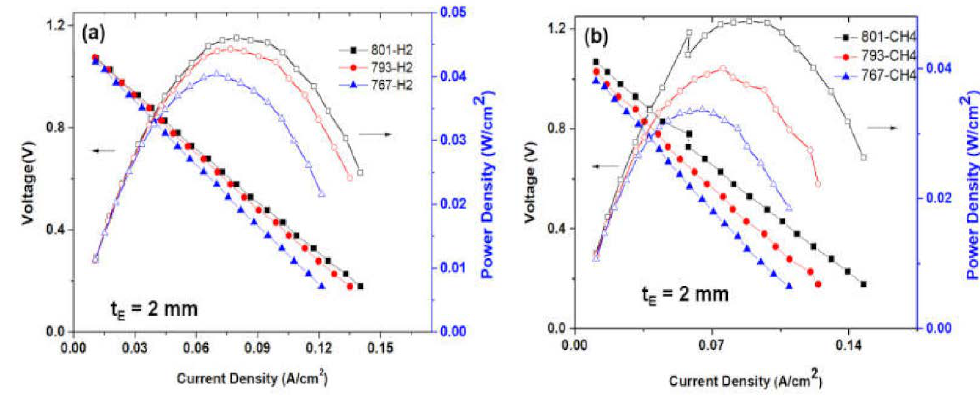
Figure 14. Performance of 2 mm electrolyte-supported SOFC with Ni 0.90 Cu 0.10 YSZ 0.95 GDC 0.05 anode in ( a ) H 2 fuel and ( b ) CH 4 fuel at (cid:4) 801 ◦ C, • 793 ◦ K, and (cid:78) 767 ◦ C; filled shapes correspond to the V–I curve (adapted from